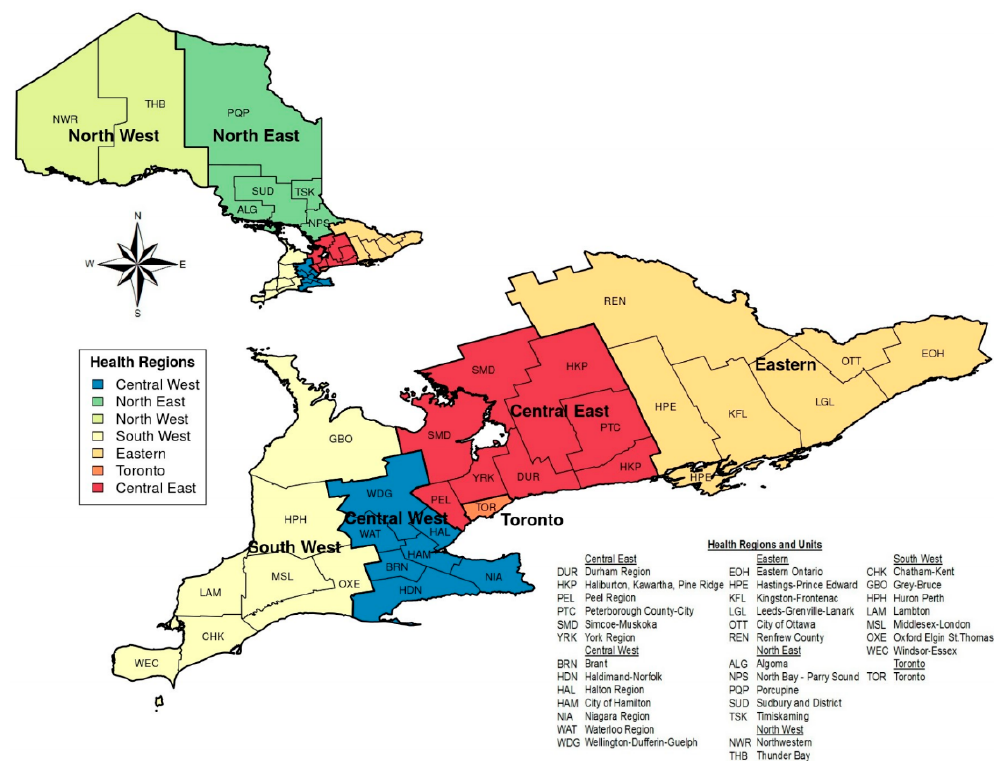
Figure 1. Public health regions and the corresponding public health units in Ontario; Source: Map created using Public Health Ontario boundary files [97].